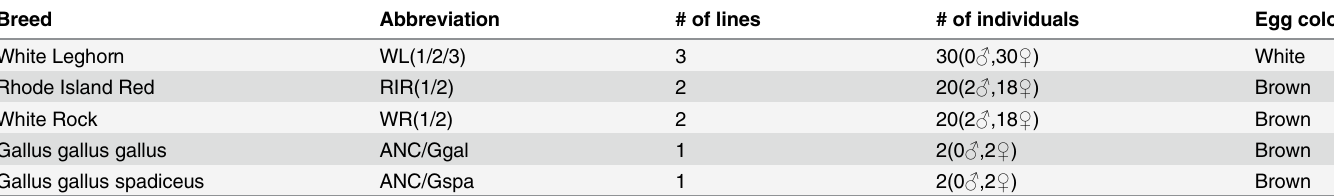
Table 1. Name, abbreviation, number of individuals and the egg color for each breed used in this